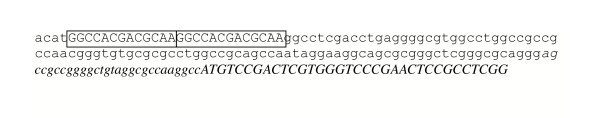
Sequence of FANCA promoter allele in the polymorphic region. Allele 1 has a single copy of a 13 base pair sequence. This has been defined as GGCCACGACGCAA in accordance with current nomenclature for mutations [21] although it could theoretically be GCCACGACGCAAG or CCACGACGCAAGG. Allele 2 has two tandemly arranged copies of this sequence. The 13 base pair sequence is located at -98 to -110 bases upstream of the beginning of transcription as defined by the NCBI reference sequence NM_000135.1. Exon 1 is in bold and the coding sequence in capitals.